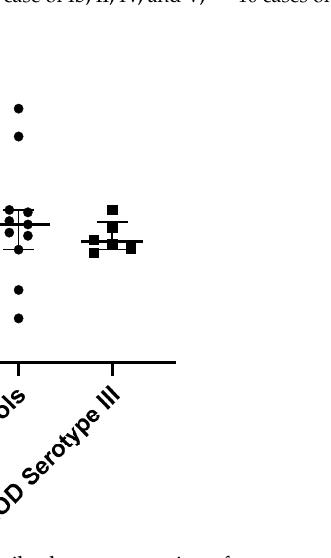
Figure 2. IgG antibody concentrations for serotype III LOD cases vs. controls. Median and interquar- tile ranges of IgG levels shown. On the left, controls ( n = 11); on the right, cases ( n =